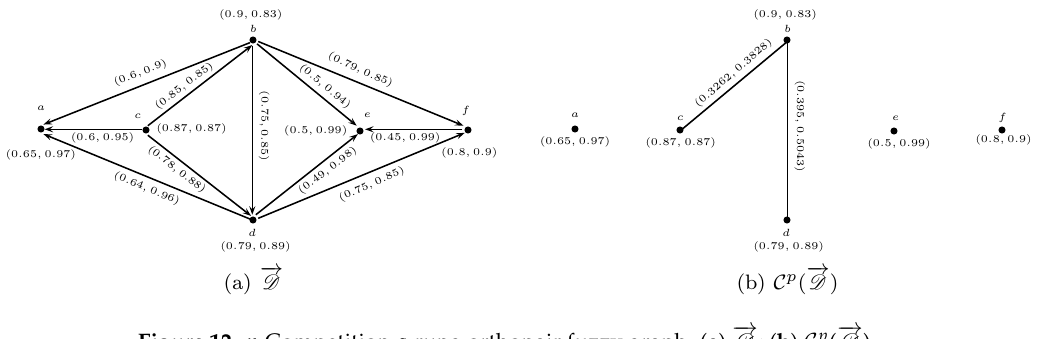
Figure 12. p -Competition q -rung orthopair fuzzy graph. ( a ) −→ D ; ( b )